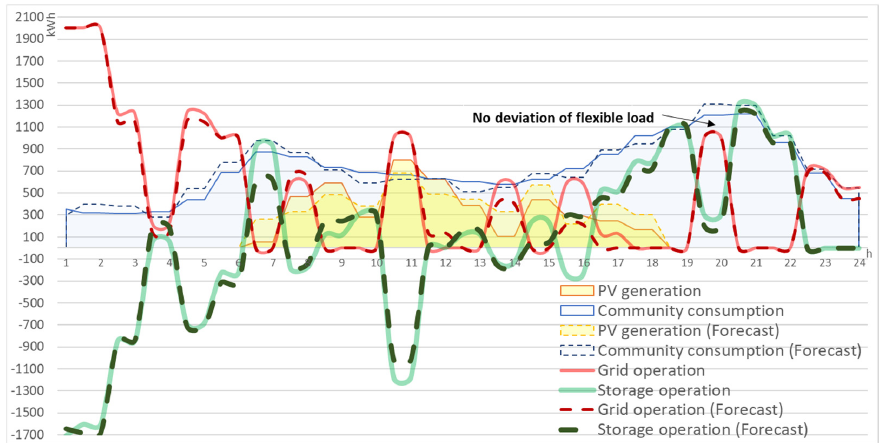
Figure 10. Twenty-four hours of OPF operation (summer).